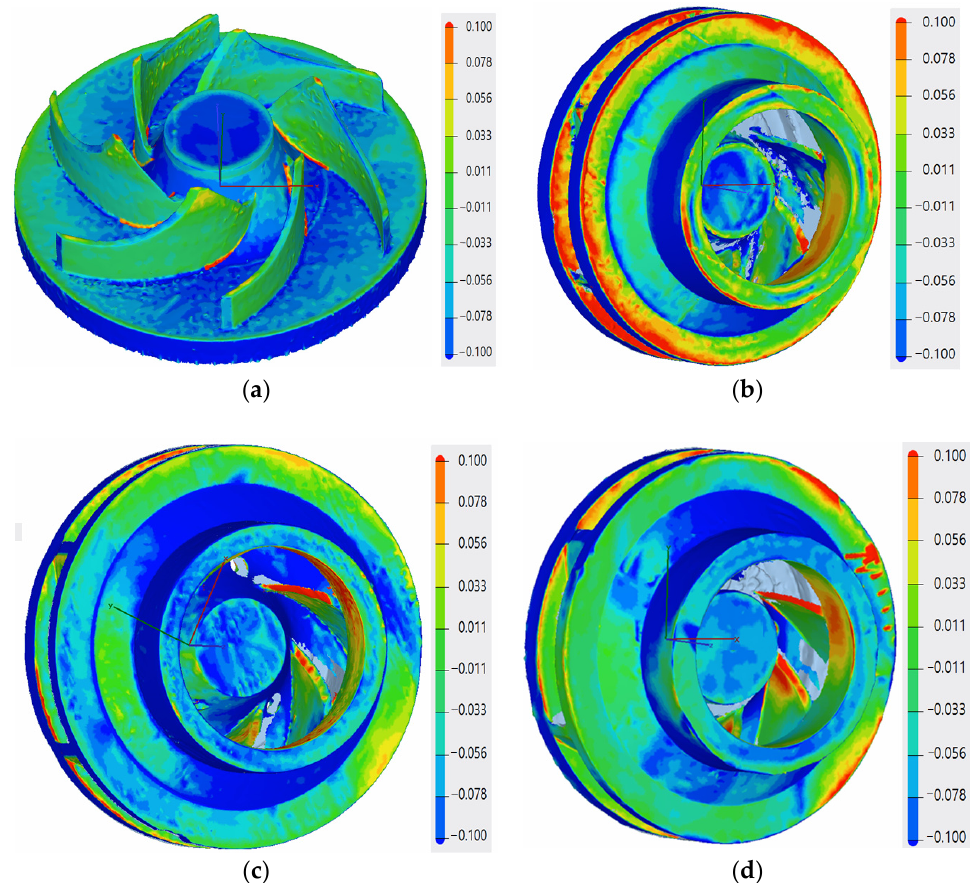
Figure 6. Exterior geometrical evaluation of the AM impellers: ( a ) evaluation of the open impeller for 0 ◦ ; ( b ) evaluation of the closed impeller for 0 ◦ ; ( c ) evaluation of the closed impeller for 32 ◦ ; ( d ) evaluation of the closed impeller for 45 ◦